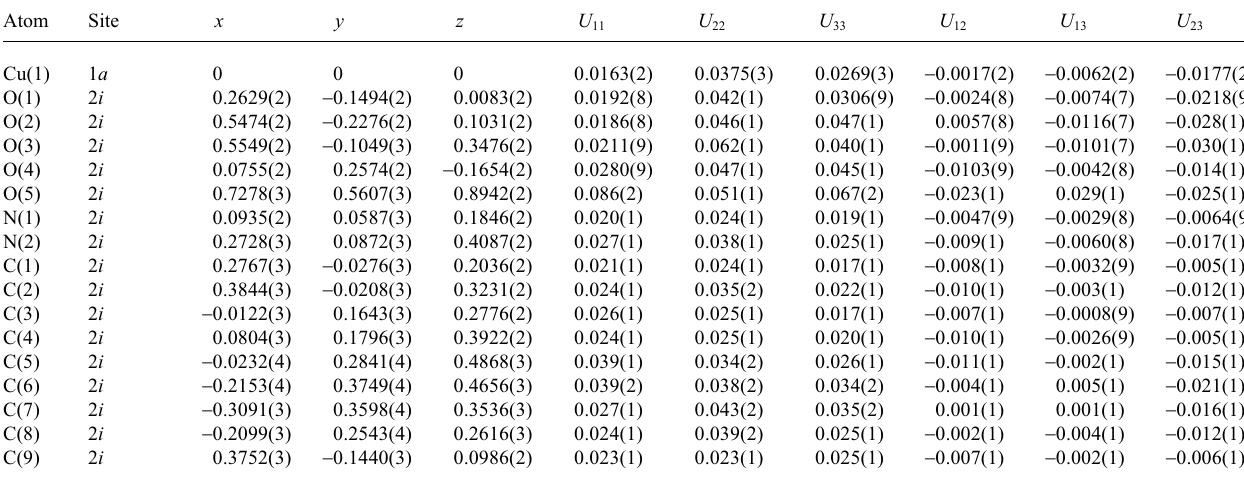
Table 3. Atomic coordinates and displacement parameters (in Å 2